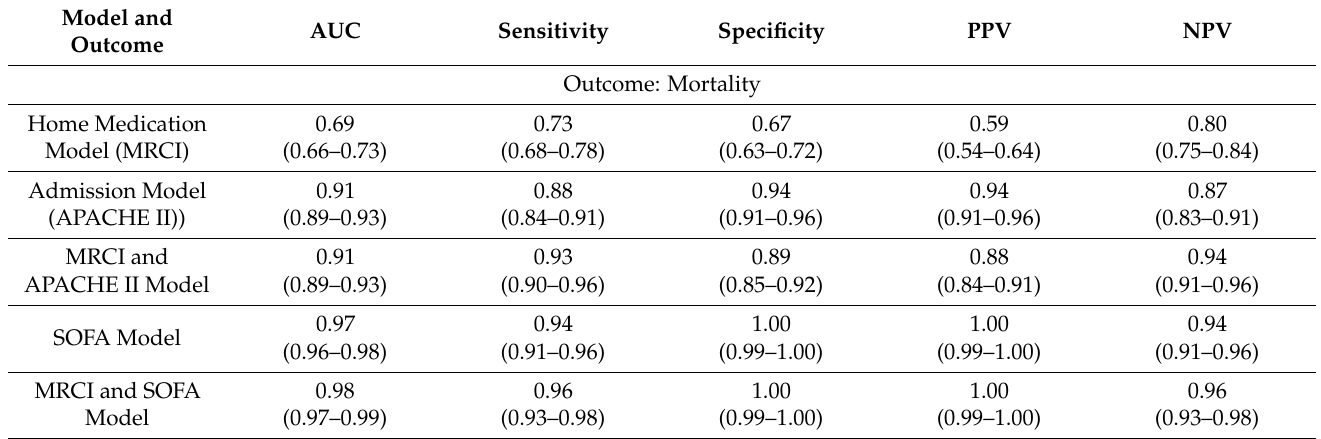
Table 2. Performance of machine learning algorithms across several models and